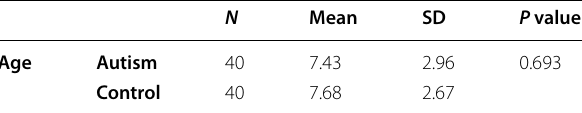
Table 1 Comparison between the age of the patient group and control group